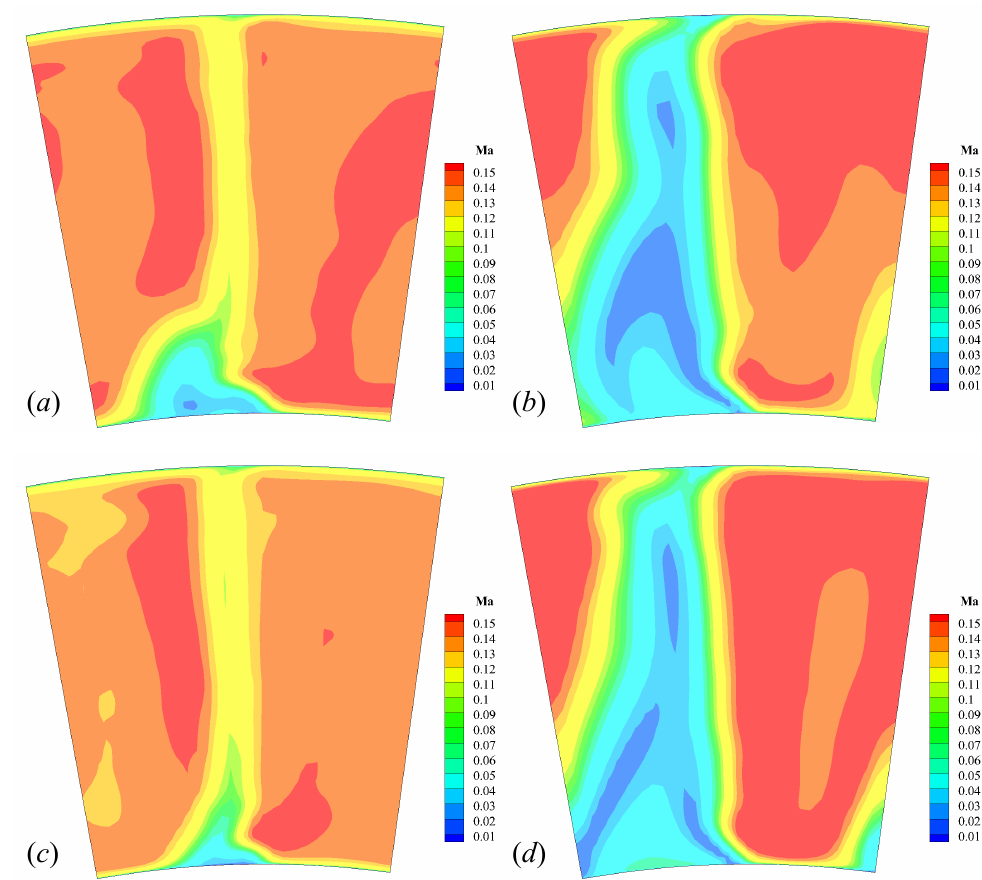
Figure 18. Distributions of Ma at the downstream section 40% c a to the stator’s trailing edge: ( a ) g = d 0 and φ = 0.318; ( b ) g = d 0 and φ = 0.241; ( c ) g = 0.1 d 0 and φ = 0.318; ( c ) g = 0.1 d 0 and φ =